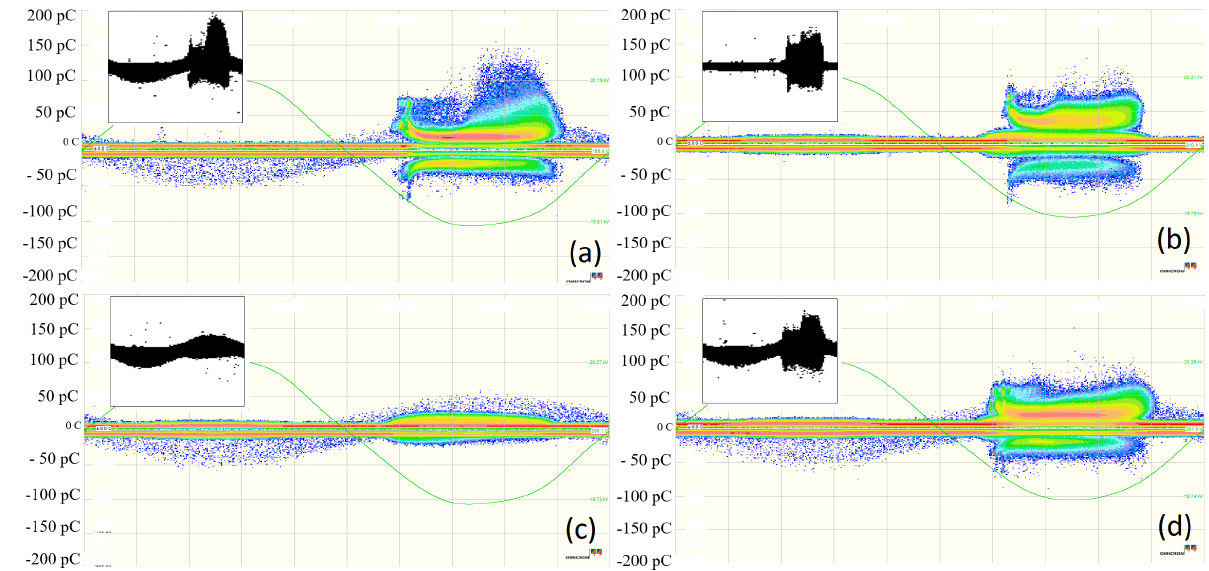
Figure 5. PRPD patterns and their binary representation of various multiple defects: ( a ) class 14; ( b ) class 16; ( c ) class 46; ( d ) class 146.